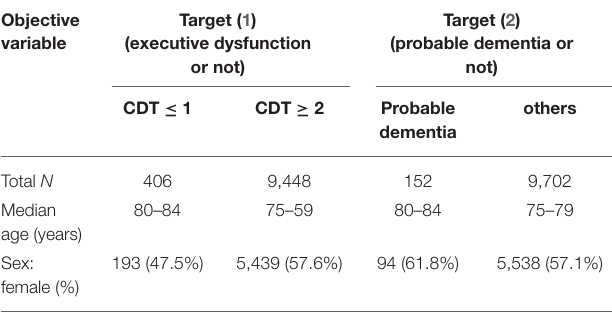
TABLE 1 | Basic characteristics of